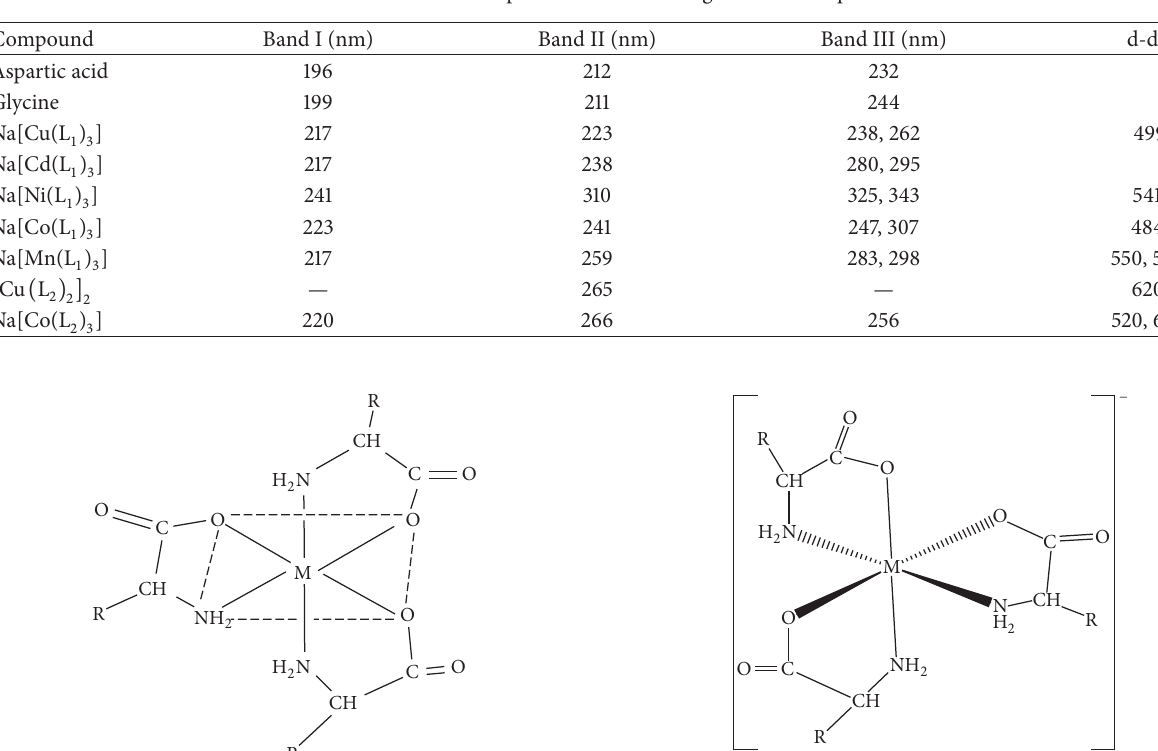
Table 2: Electronic spectra bands for the ligands and complexes.